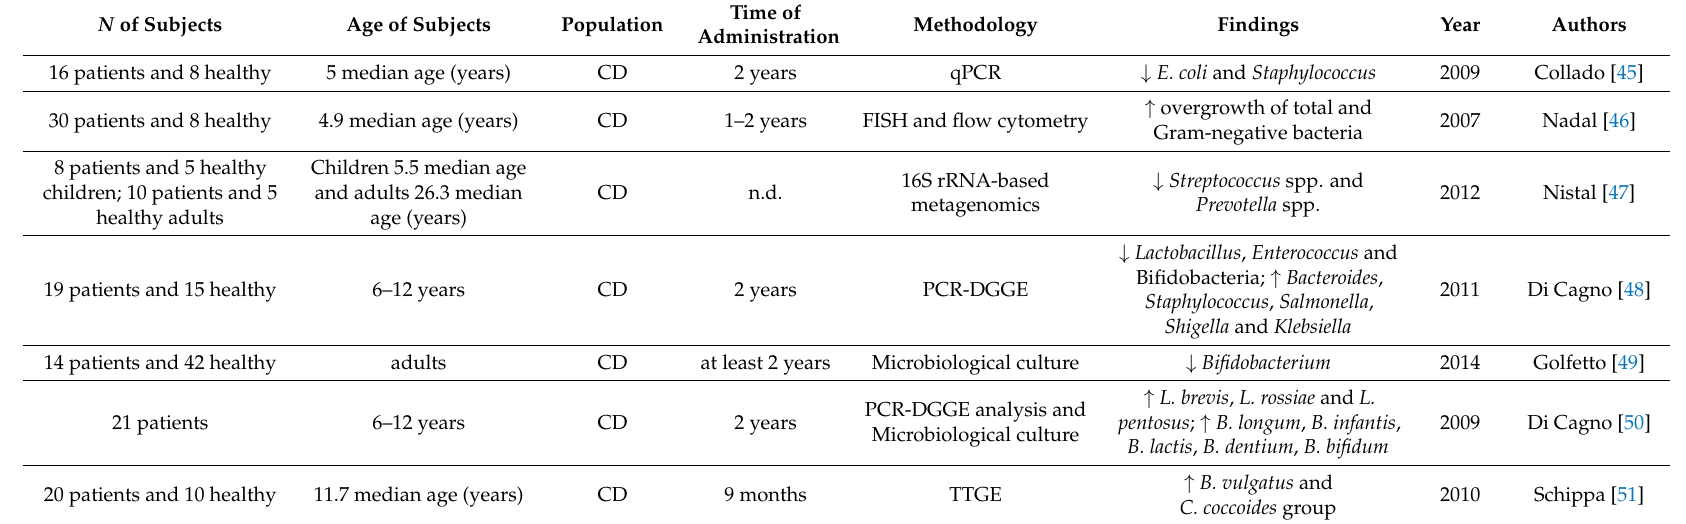
Table 2. Main findings related to the effect of gluten-free diet (GFD) on gut microbiota in celiac disease